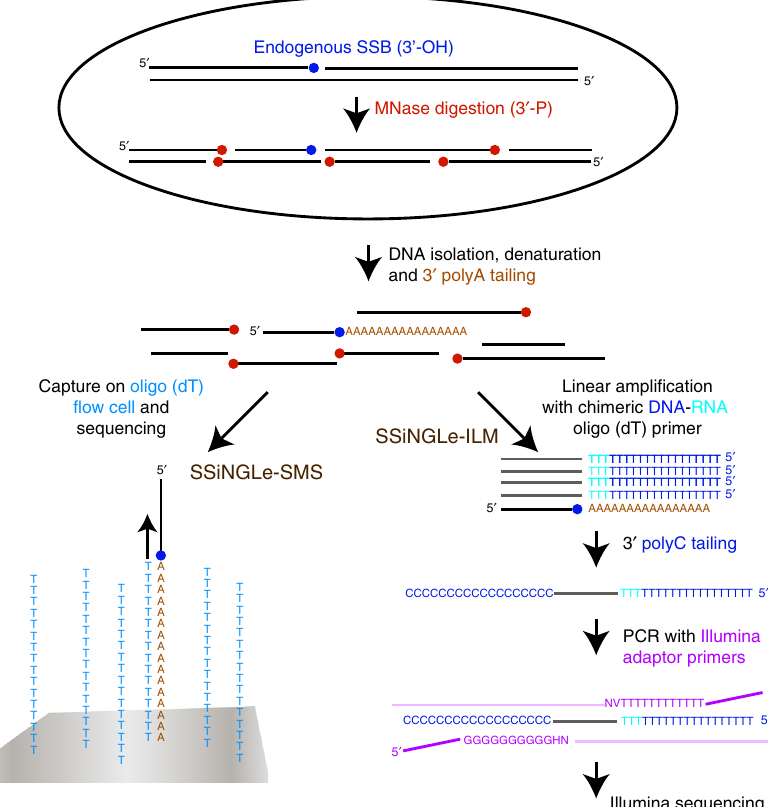
Fig. 1 Overview of SSiNGLe-SMS and SSiNGLe-ILM. DNA with 3 ′ -OH SSB (blue circle) is fragmented in situ with MNase that leaves 3 ′ -P termini (red circles) that cannot be tagged with the polyA using TdT. After tailing, the native DNA is either sequenced directly on oligo(dT) fl ow cells (SSiNGLe-SMS) or put through the additional depicted steps for